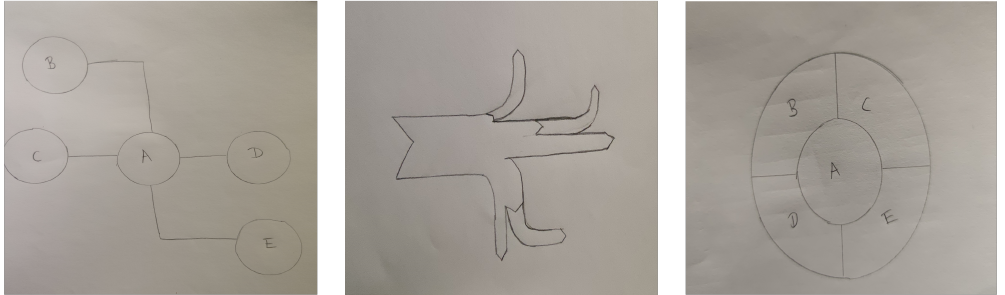
Figure 4. Explore: Visualizing similar interests.